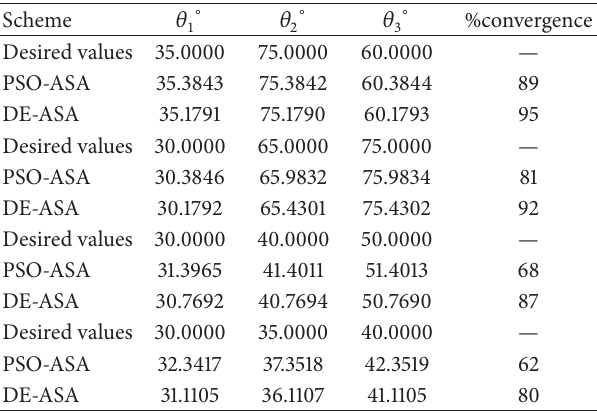
Table 6: Proximity effect of elevation angles for 𝑠 1 = 1, 𝑠 2 = 3, 𝑠 3 = 5